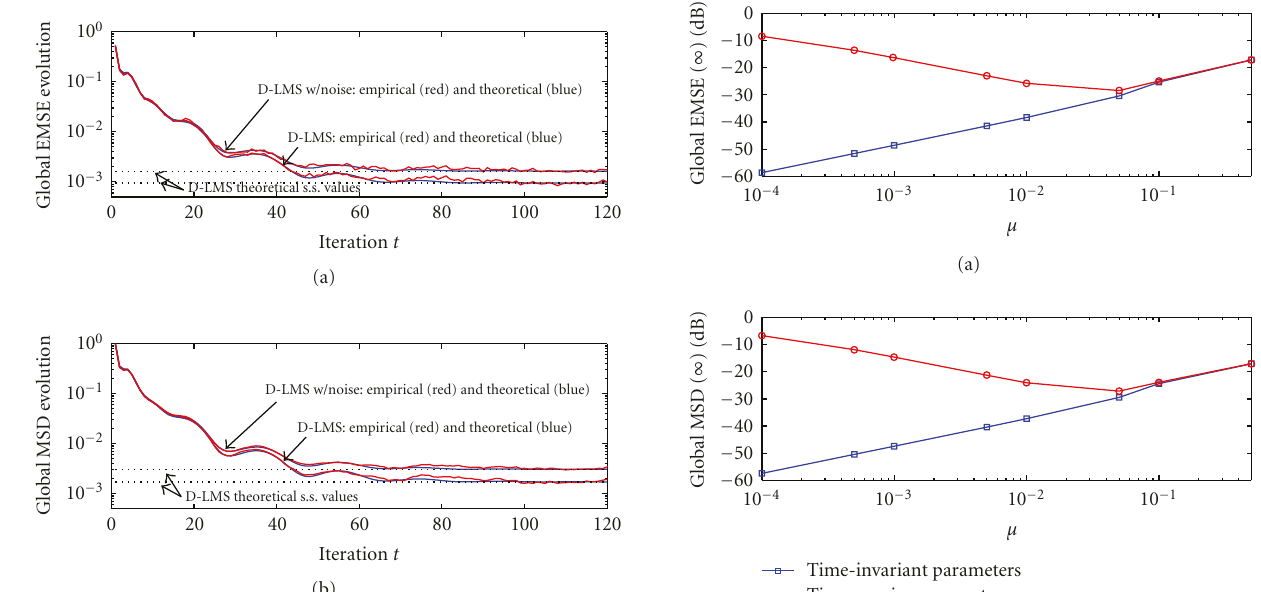
nate newly acquired sensor data across the WSN. The novel scheme does not require a Hamiltonian cycle or a subset of bridge sensors, and can tackle linear regression problems in which a statistical data model is not available. When communication noise is not an issue, a cost-e ff ective